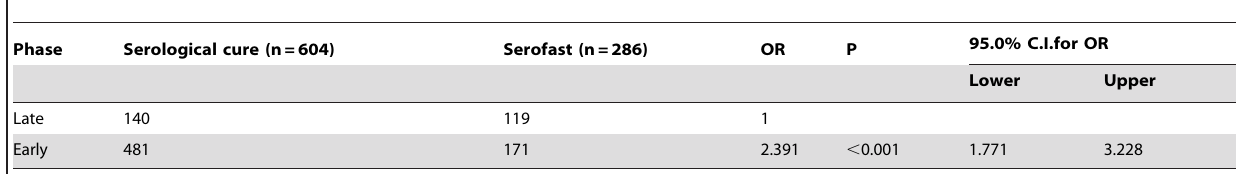
Table 3. Comparison of the responses to therapy between early and late syphilis.